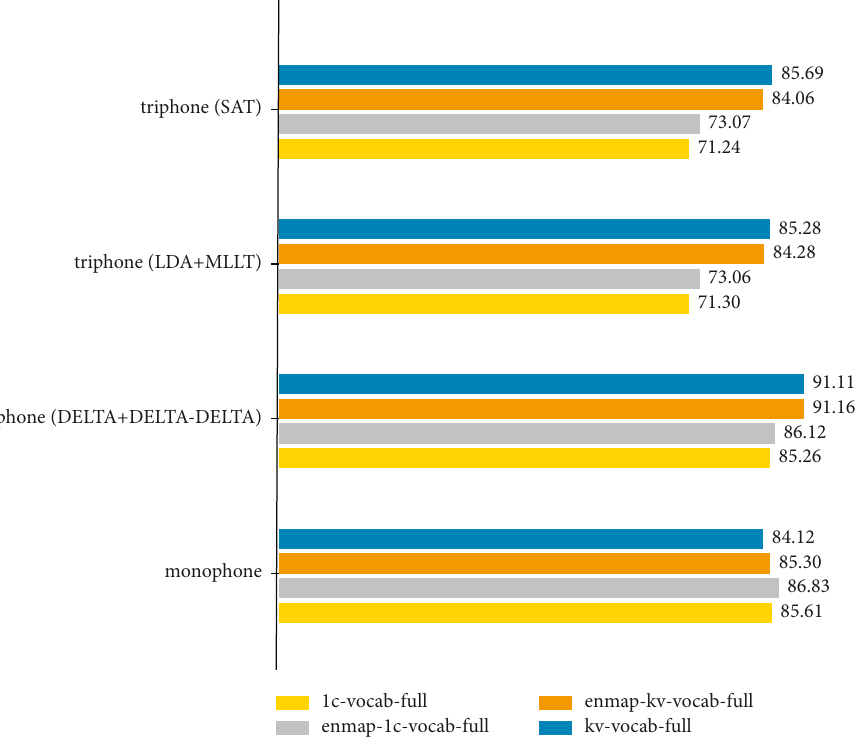
Figure 7: The %WER of the GMM-HMM models trained using 10,000 unvalidated utterances.